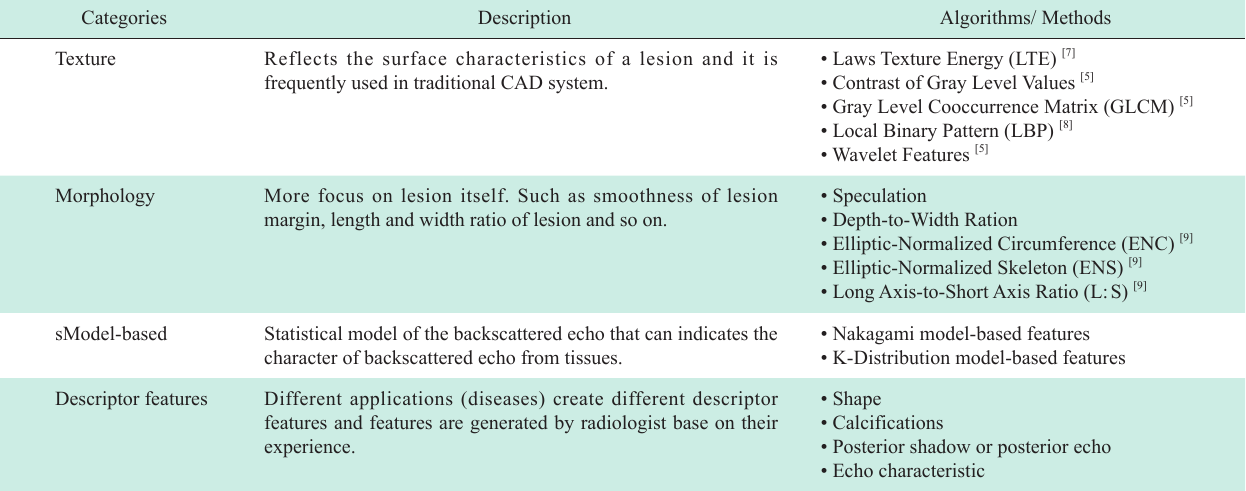
Table 1 Categories for feature selections in traditional CAD